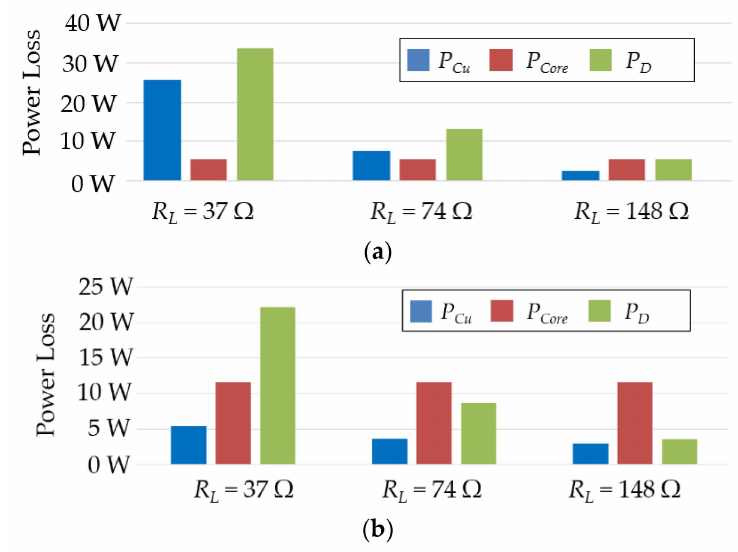
Figure 15. Power losses at different loads: The blue line is the winding loss, the red line is the core loss, and the green line is the diode rectifier loss. ( a ) CTU. ( b ) ATU.